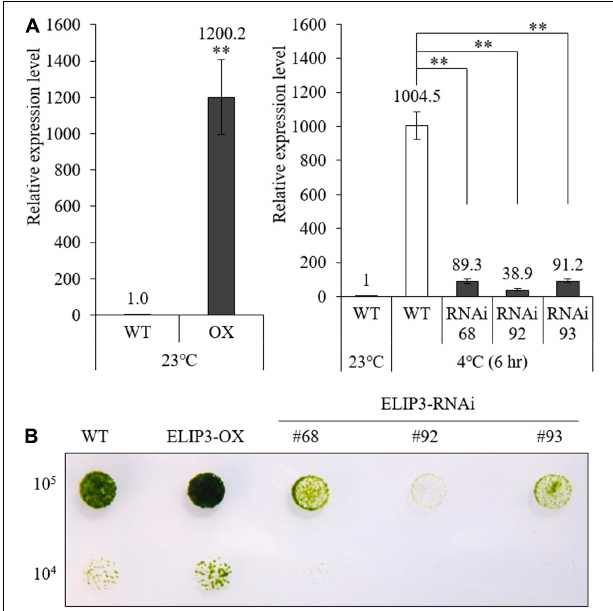
FIGURE 6 | Expression of ELIP3 in transgenic strains. (A) Transcription levels in ELIP3 overexpression strain (OX) and knockdown strains (RNAi). Data are expressed as mean ± SD. ( t -test and one-way ANOVA, ∗∗ P < 0.01, n = 3). (B) Viability analysis using spot assay with TAP agar plate under low temperature. Cells of each strain (10 5 cells/ml, 10 4 cells/ml) were dispensed in the TAP agar plate and incubated at 10 ◦ C for 30